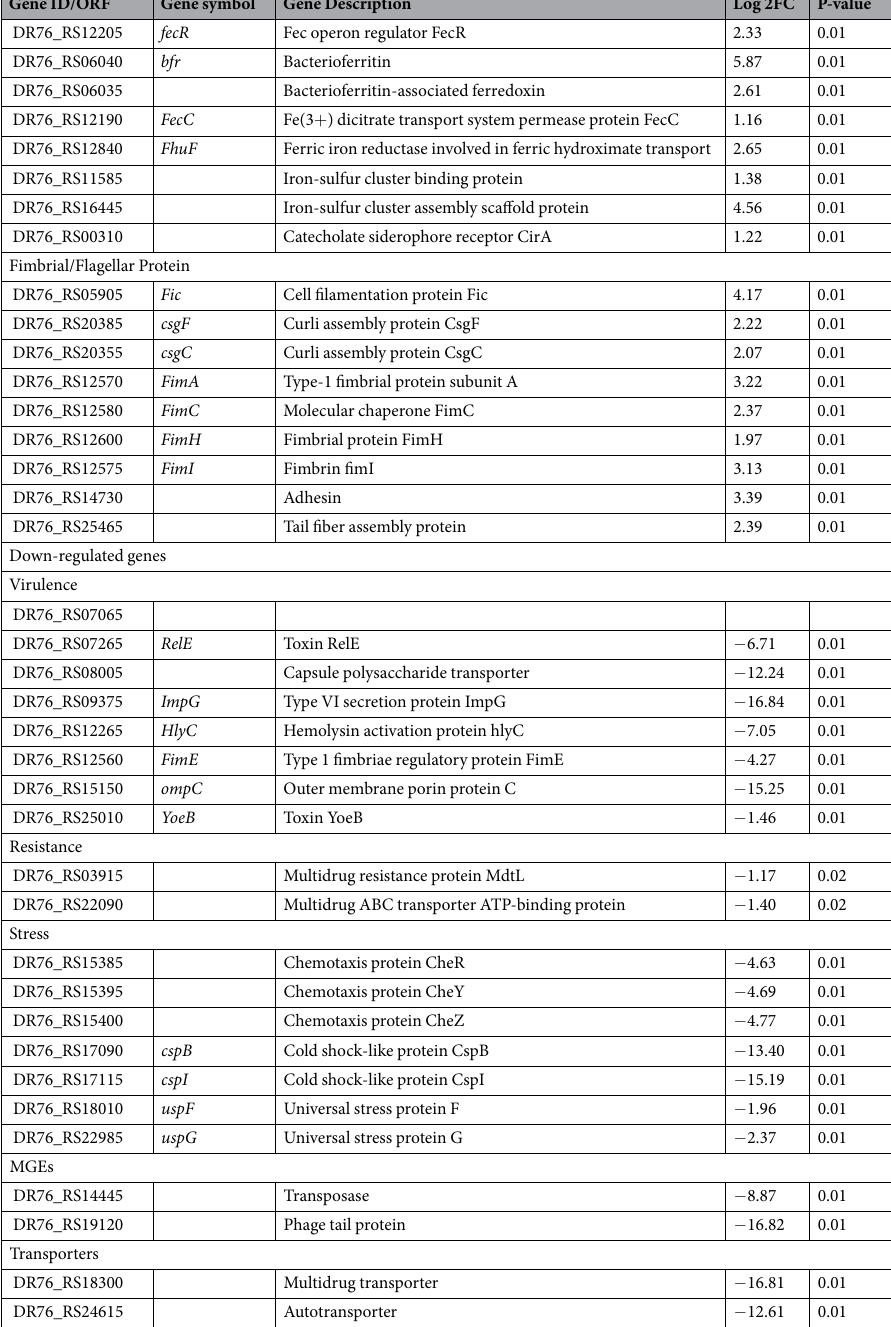
Table 4. Important up-regulated and dwown-regulated genes in E. coli